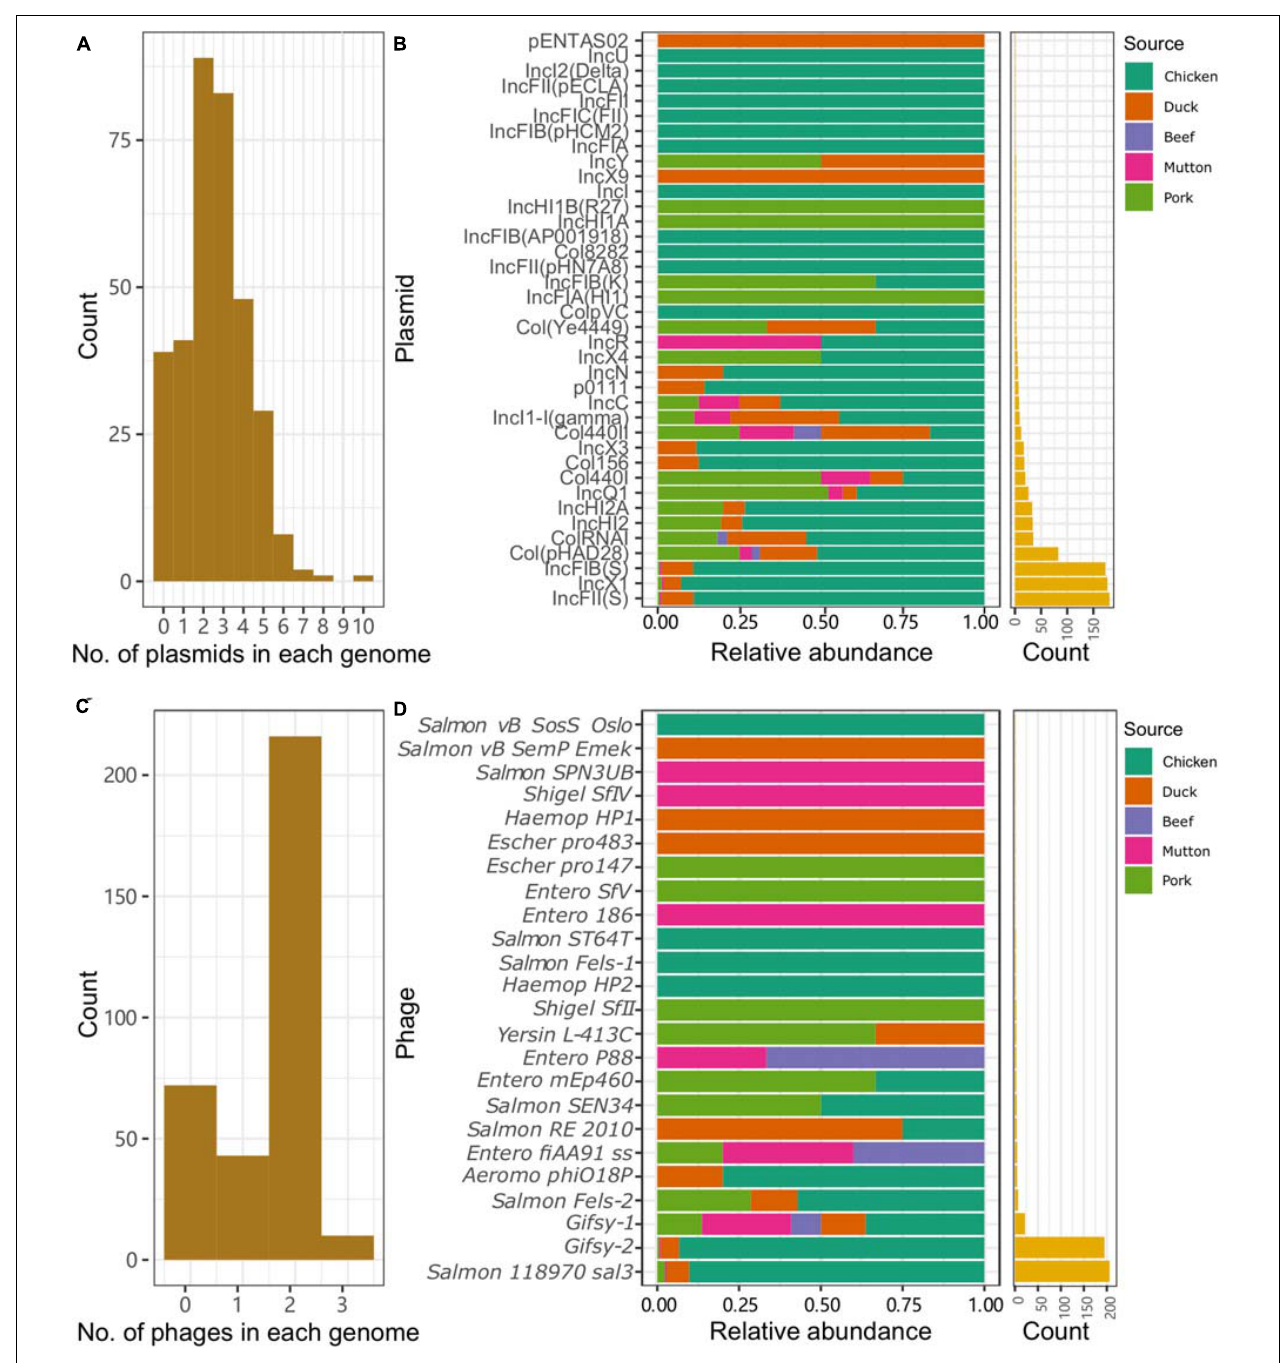
FIGURE 3 | Plasmids and prophages in the Salmonella genome. (A) Number of plasmids in each genome. (B) Distribution of different plasmids in the genomes of Salmonella isolates from different retail meats. (C) Number of prophages in each genome. (D) Distribution of different prophages in the genomes of Salmonella isolates from different retail